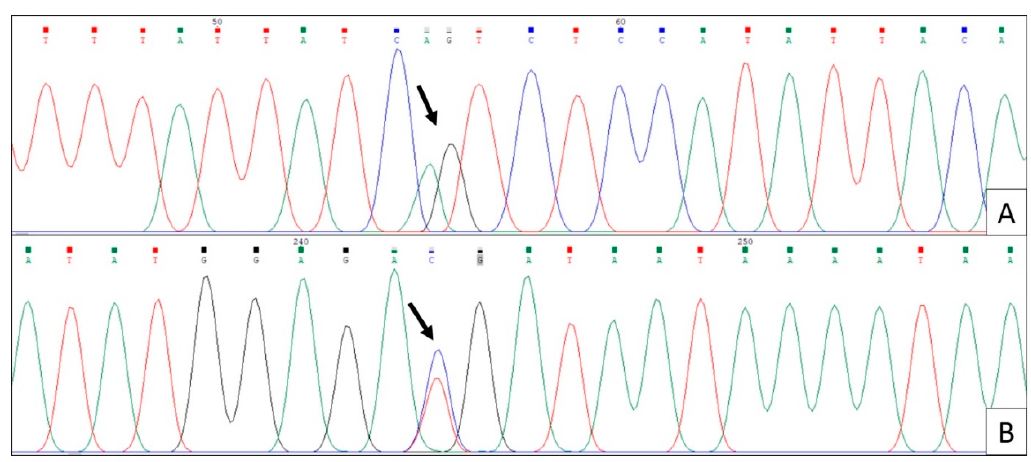
Figure 2. The chromatogram showing ENAM with the AG / TC variant alleles. ( A ) Forward direction. ( B ) Reverse direction.